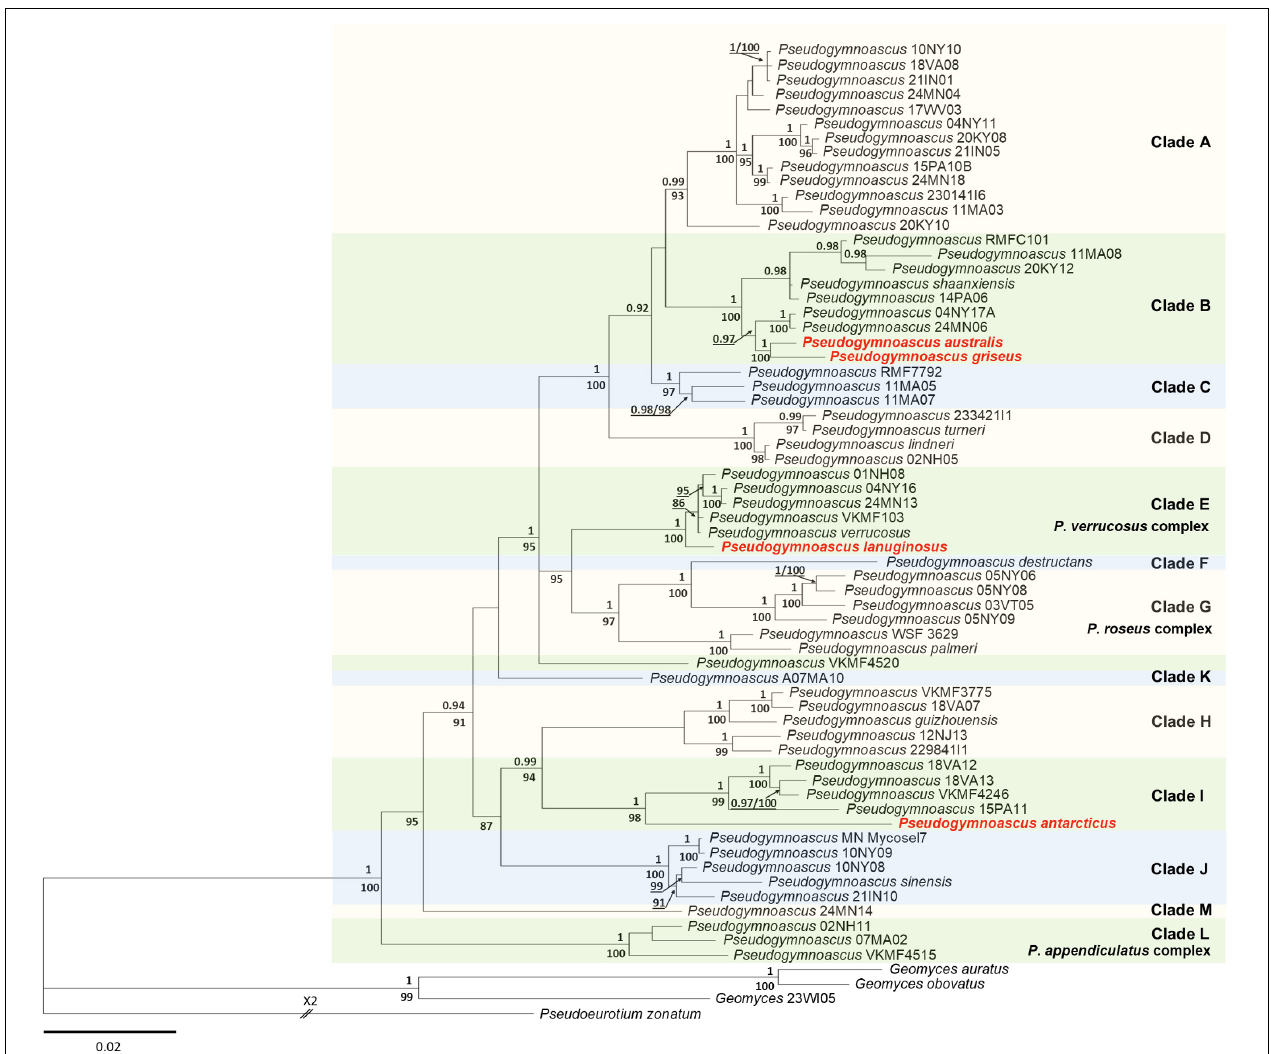
FIGURE 1 | Bayesian inference phylogenetic tree of Pseudogymnoascus generated from the concatenated dataset of five loci (ITS, LSU, TEF1, RPB2, and MCM7). Bayesian posterior probabilities (BPPs) are indicated above branches and significant ML bootstrap (BS) values below branches. Only clades that received ≥ 80% BS and ≥ 0.95 BPP simultaneously were considered strongly supported and presented at the nodes. Clades are identified using clade nomenclature (A to M) formally defined by Minnis and Lindner (2013). The scale bar indicates 0.02 nucleotide changes per site. The new species are highlighted in bold and